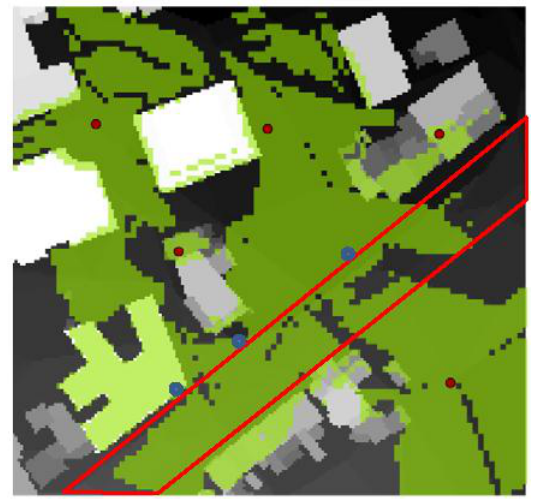
Figure 23. Coverage map of deploying eight sensors using the context-aware method, considering the street (Zone 1) as the desired region to be covered (the red